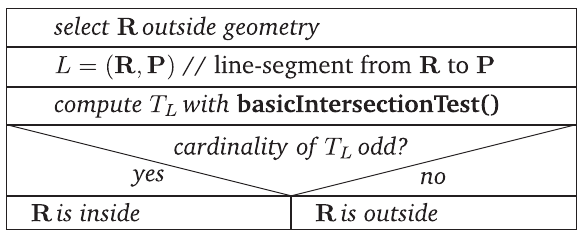
is also depicted at r L